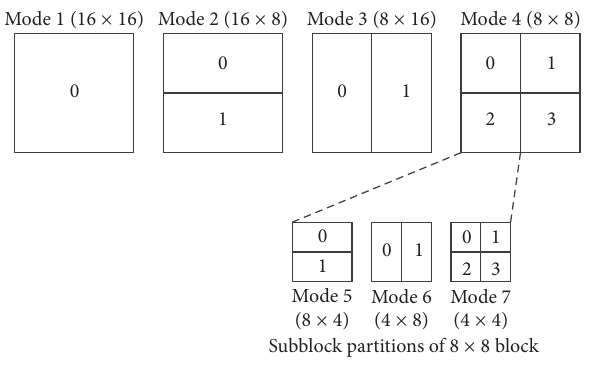
Figure 1: Macroblock modes